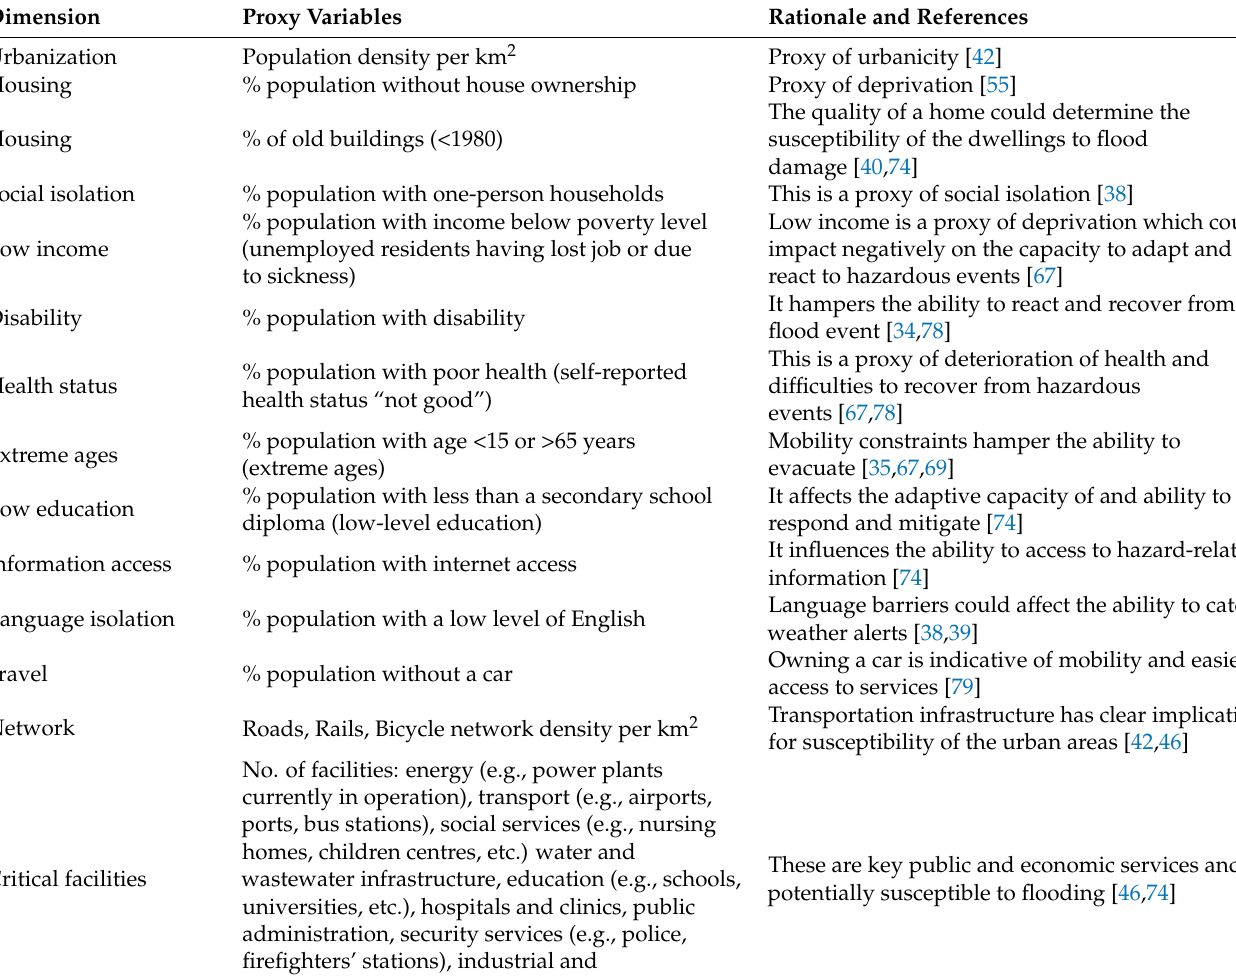
Table 2. Variables used to assess vulnerability, related socioeconomic and physical aspects and rationale for inclusion, with